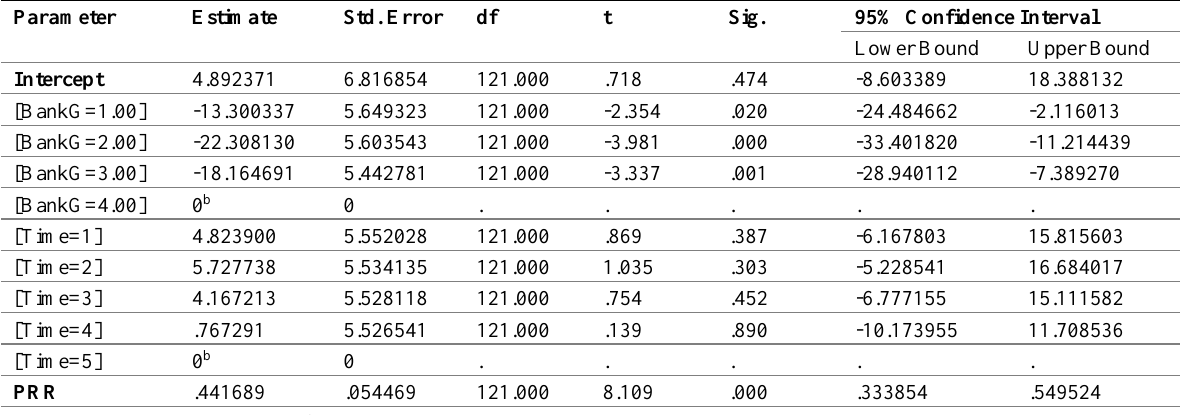
Table 4: Type III Tests of Fixed Effects a (Profit Verse time, bank Category and PR)